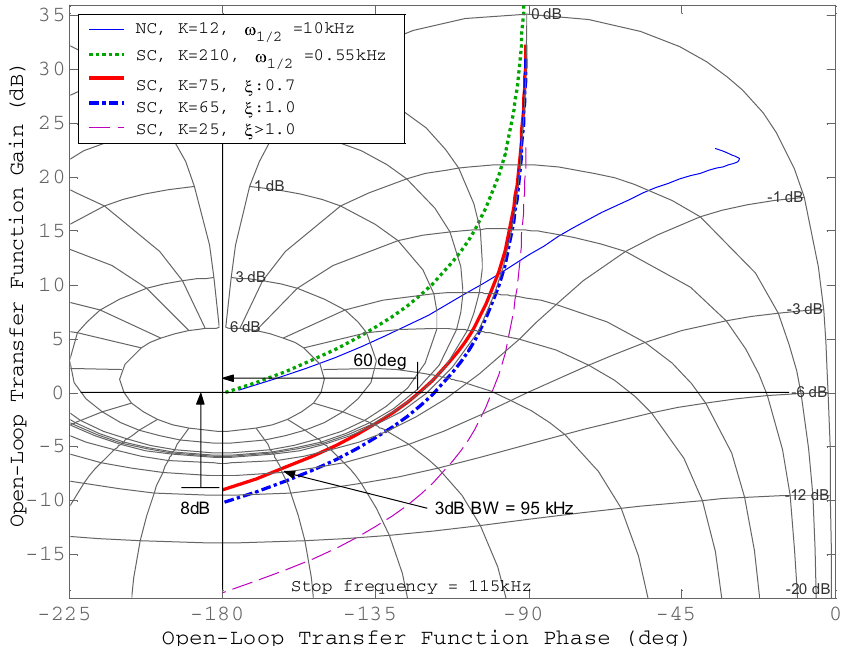
FIG. 4. (Color) Graphical analysis with Nichols chart for the performance and stability of SNS rf control system. A worst case of 2 (cid:1) sec loop delay is